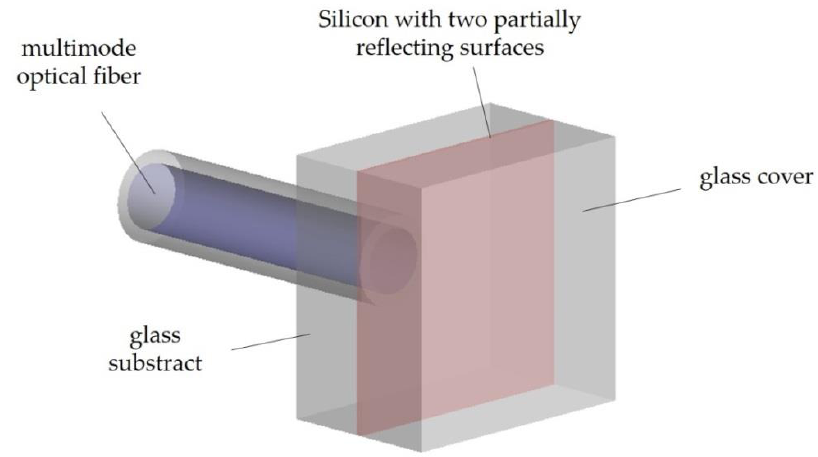
Figure 4. Schematic drawing of the temperature sensor proposed by Wolthuis et al. (Adapted from [109].)